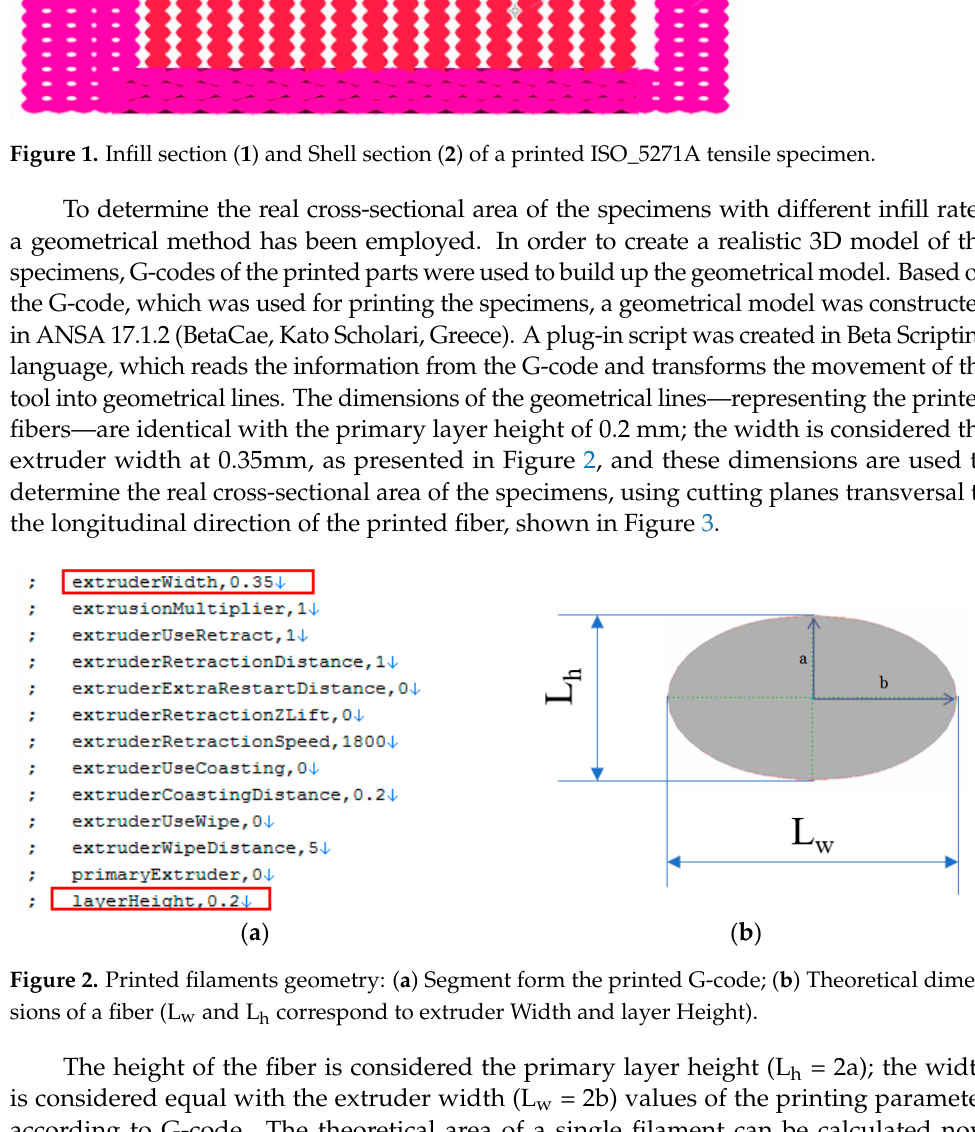
Figure 1. Infill section ( 1 ) and Shell section ( 2 ) of a printed ISO_5271A tensile specimen.